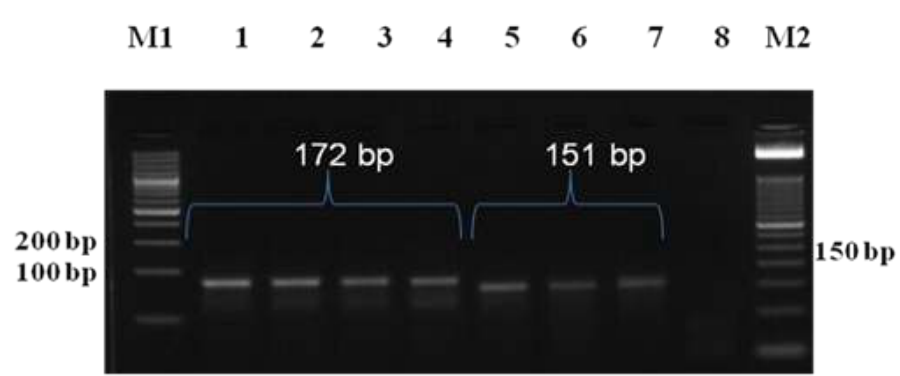
Figure-1. RPO30 gene based PCR assay for differentiation of SPPV and GTPV. Lanes M1-100 bp plus ladder, M2-50 bp ladder, Lanes 1-4 GTPV positive samples, Lanes 5-7 SPPV positive samples, Lane 8 negative